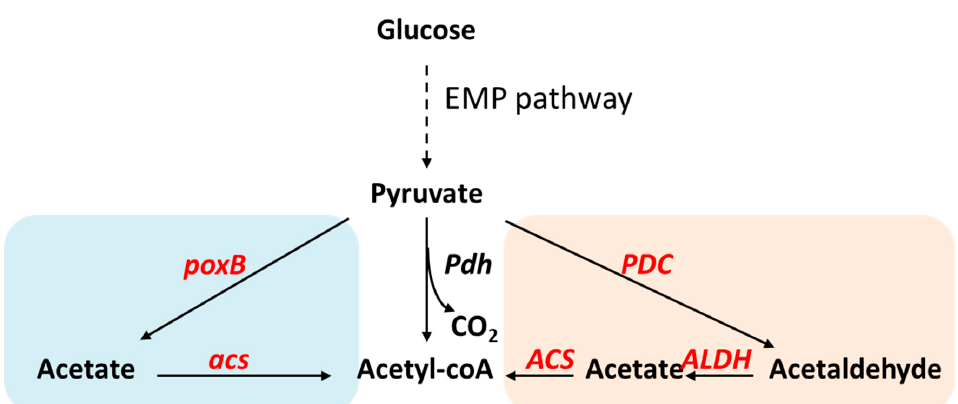
Figure 5. Scheme of pyruvate dehydrogenase (Pdh) bypass. Pdh bypass allows acetyl-CoA synthesis from pyruvate independent from Pdh. The pink area was naturally occuring in